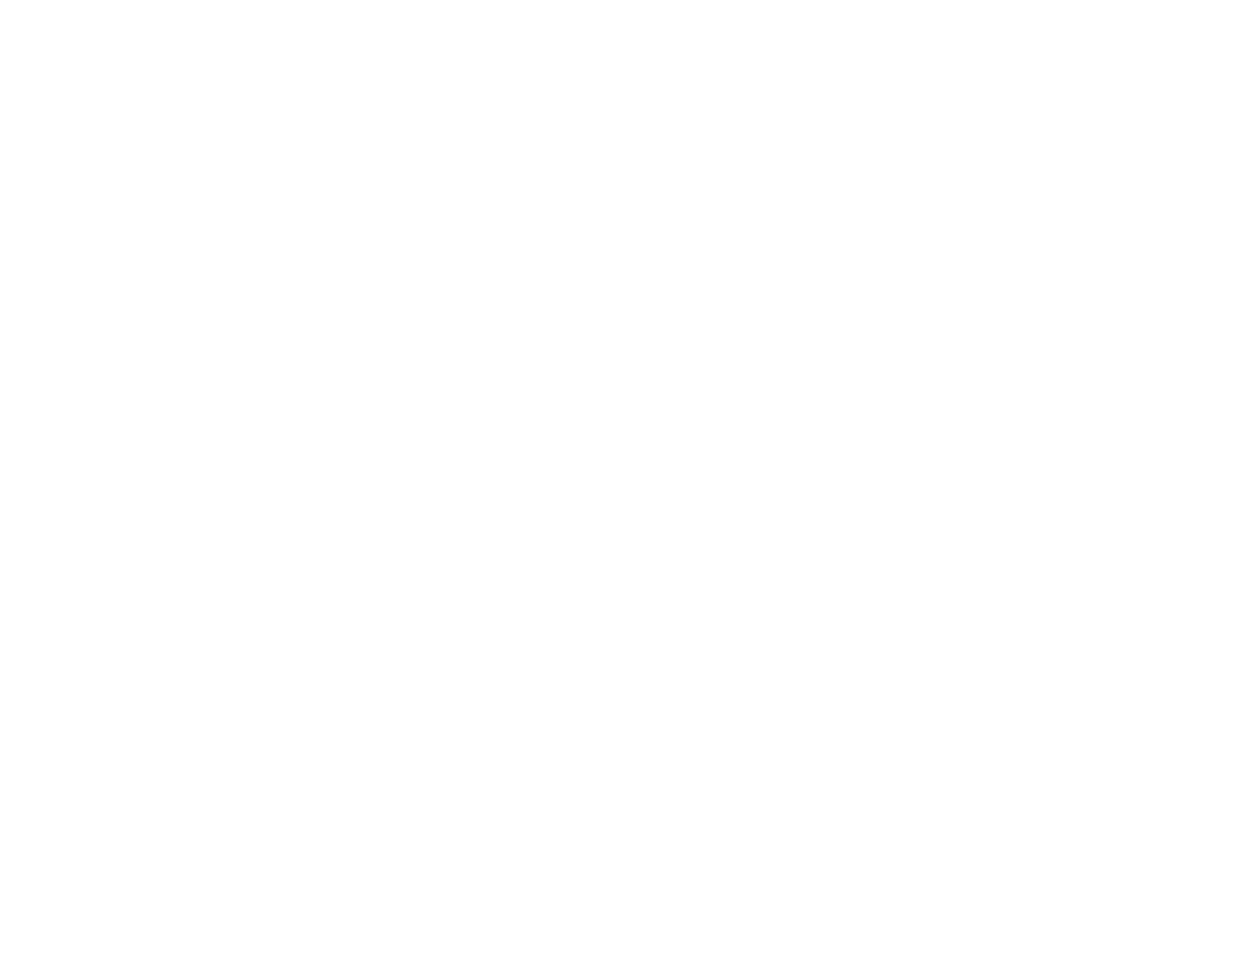
FIGURE 2 | Non-standardized solution of the hypothesized model. *** p < 0.001; ** p <